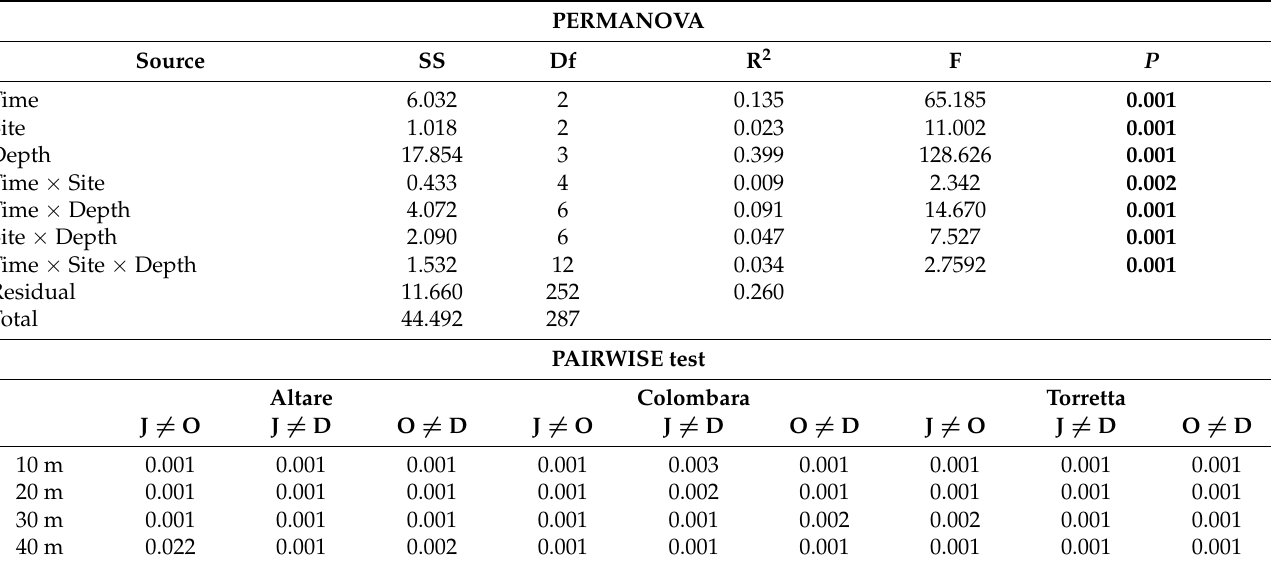
Table 2. Results of the PERMANOVA and PAIRWISE tests applied on rocky reef communities of Portofino MPA. Times = June (J), October (O), and December (D); sites = Altare, Colombara, and Torretta; depth = 10, 20, 30, and 40 m.